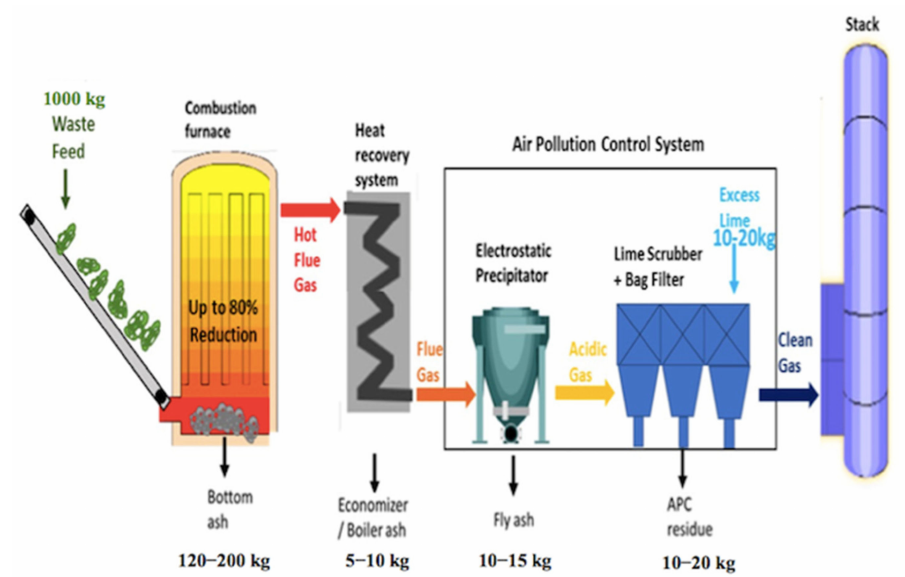
Figure 1. The mass fraction of residues in MSW